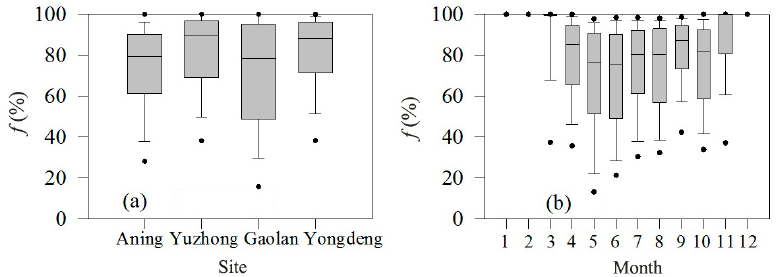
Figure 9. Regional ( a ) and monthly ( b ) variations of f in precipitation. Water 2021 , 13 , x FOR PEER REVIEW